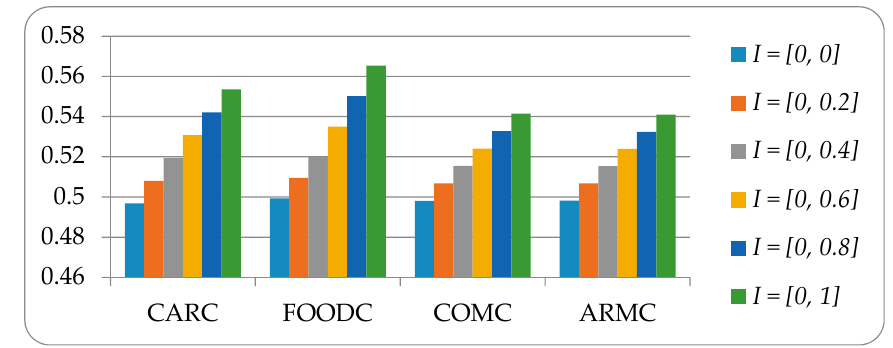
Figure 4. Ranking order with variation of ‘ I ’ on NNs for Strategy 2.